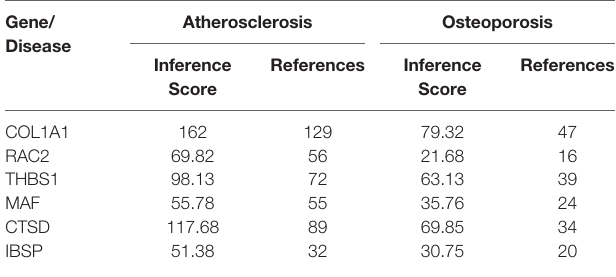
TABLE 2 | The hub genes associated with atherosclerosis and osteoporosis in CTD. Gene/ Atherosclerosis Osteoporosis Disease Inference